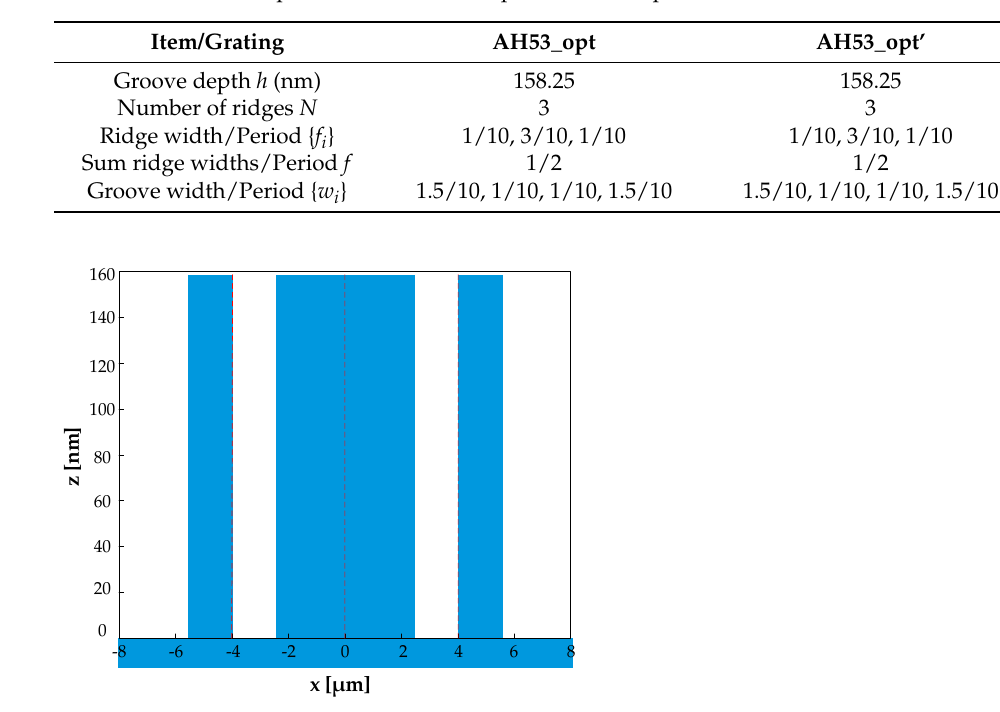
Table 1. The structure parameters of AH53_opt and AH53_opt’.